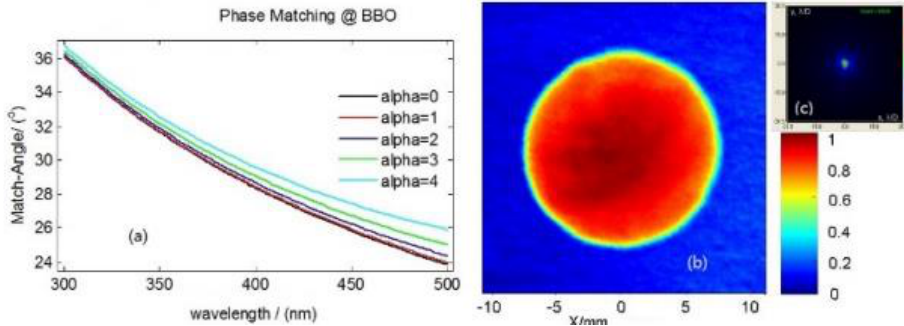
Figure 2. Calculations of phase-matching angle of the BBO crystal at 404 nm and 1064 nm ( a ); spatial profile of the sheared pump pulse (1064 nm) ( b ); far-field distribution of the sheared pump pulse (1064 nm) ( c ).